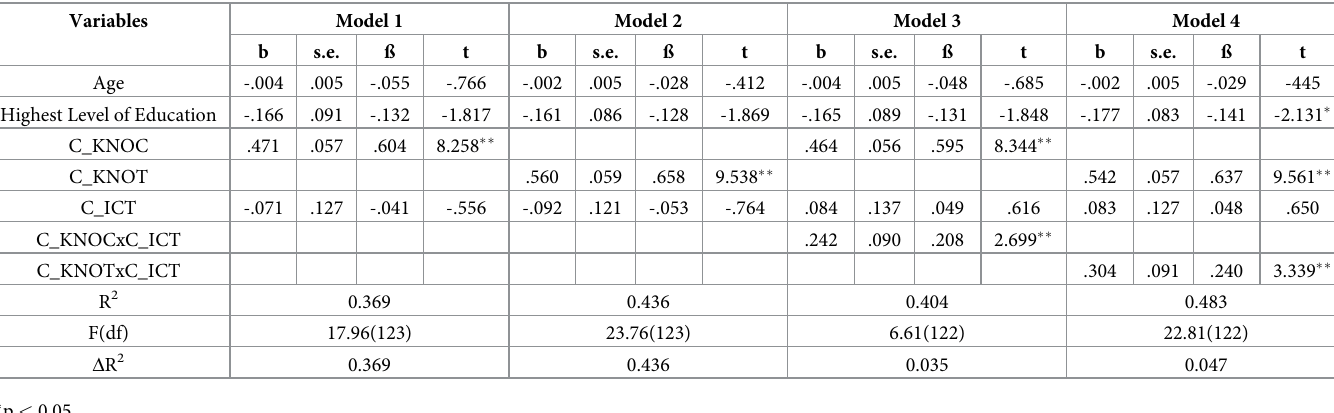
Table 3. Hierarchical regression analysis predicting quality of healthcare services–models